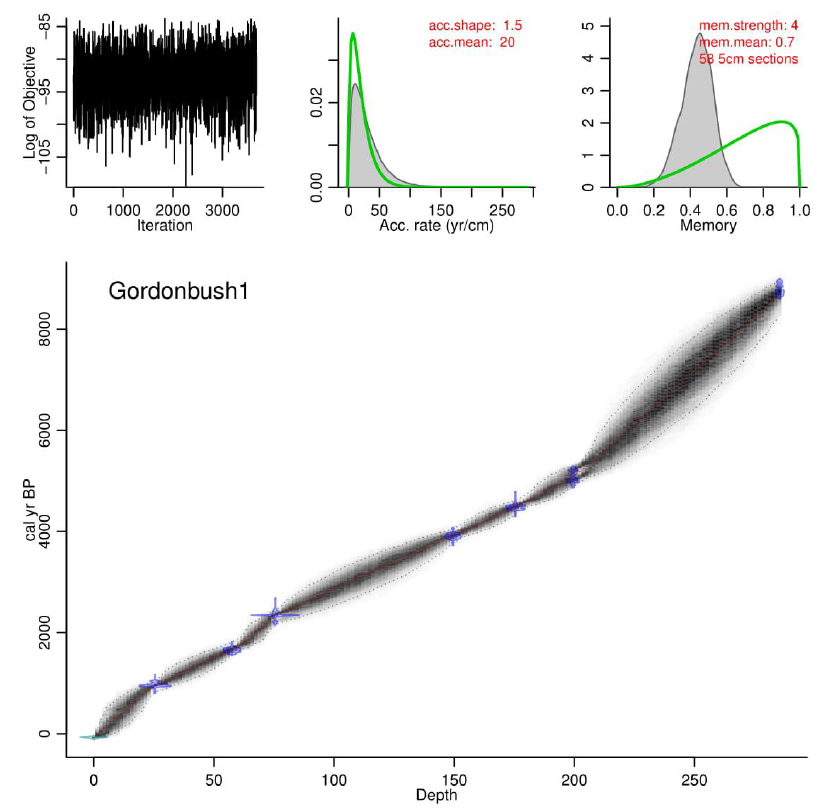
Figure A3i. Age-depth model produced in BACON for GB1.